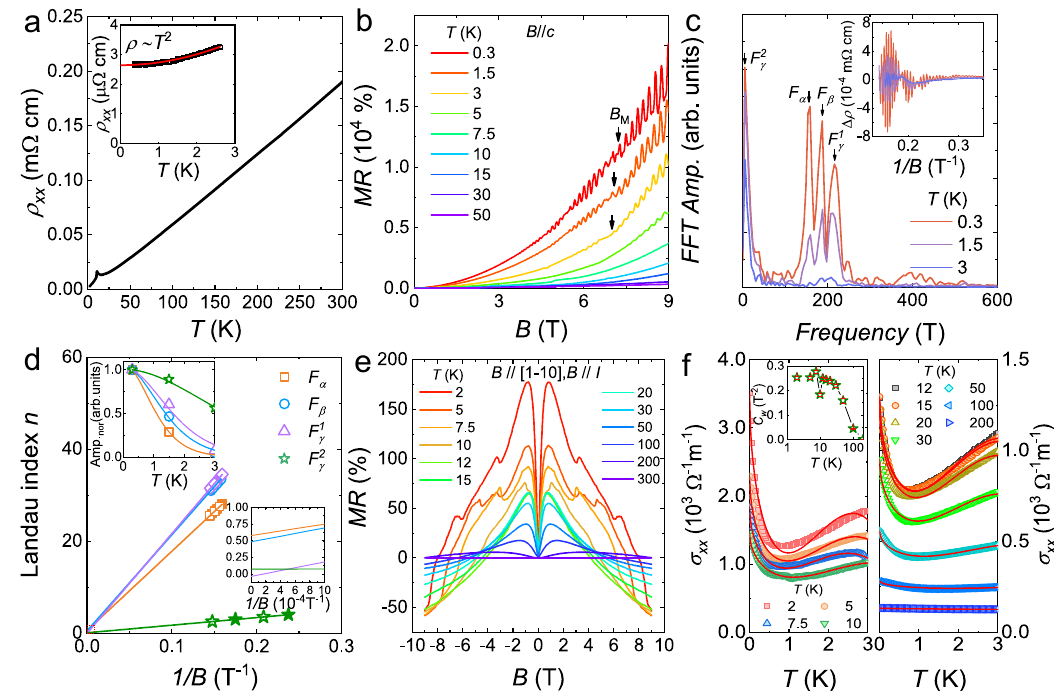
Fig. 2 Quantum oscillations and negative longitudinal magnetoresistance ( n -LMR) in the antiferromagnetic state of EuAs 3 . a Resistivity of EuAs 3 single crystal in zero magnetic fi eld. The inset shows the fi t to the low-temperature data. b MR accompanied by distinct SdH oscillations. B M represents the critical magnetic fi eld, which induces a magnetic transition from a collinear antiferromagnetic phase to a polarized ferromagnetic phase. c FFT results at various temperatures. The inset displays the oscillatory component ρ xx below B M . Four bands, i.e., α , β , γ 1 , and γ 2 , can be distinguished. The latter two construct one electron sheet. d Landau index n plotted against 1/ B for the SdH oscillations at 0.3 K. Lines represent linear fi ts. The right inset shows the extrapolation of 1/ B to zero. The left inset shows the normalized FFT amplitude (Amp. nor ) as a function of temperature, and the solid lines represent fi ts to the Lifshitz – Kosevich formula. e n -LMR measured with magnetic fi eld parallel to the electric current I at various temperatures. f Longitudinal conductivity at various temperatures fi t to the Adler – Bell – Jackiw chiral anomaly equation. The inset shows the emergence of a positive parameter originating from the chiral anomaly C w , and error bar of the data is determined from fi tting.